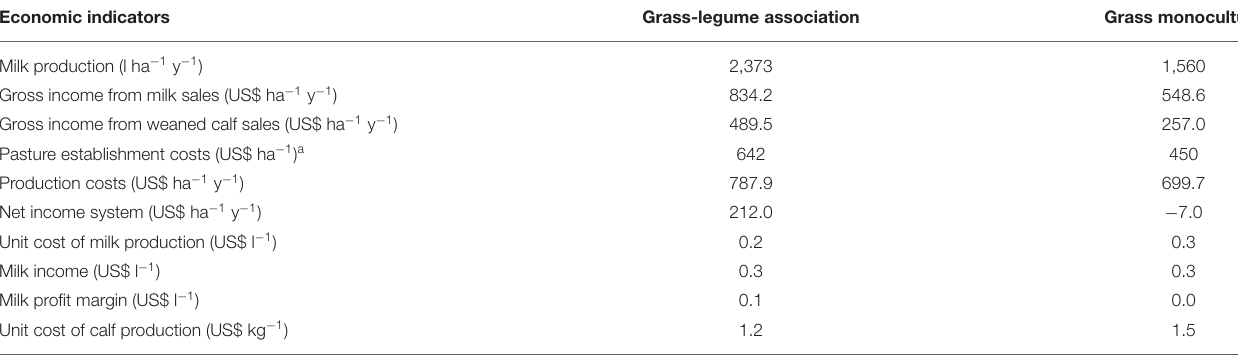
TABLE 5 | Summary of main costs and revenues for the grass-legume association and the grass monoculture. Economic indicators